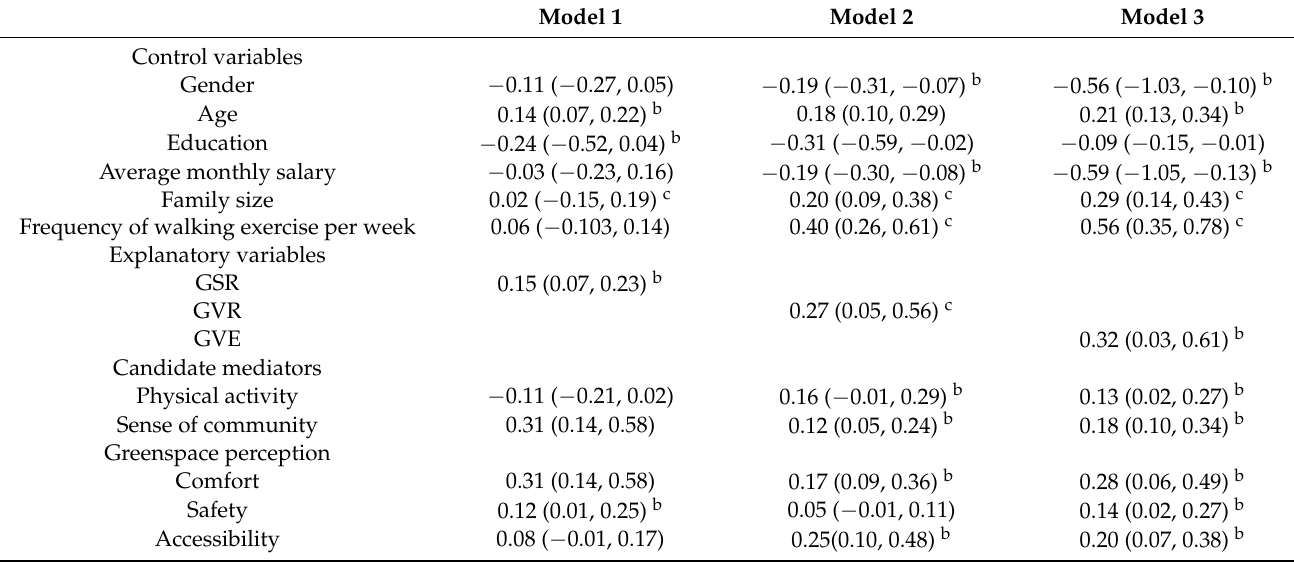
Table 8. The estimate parameters of the structure regression model.